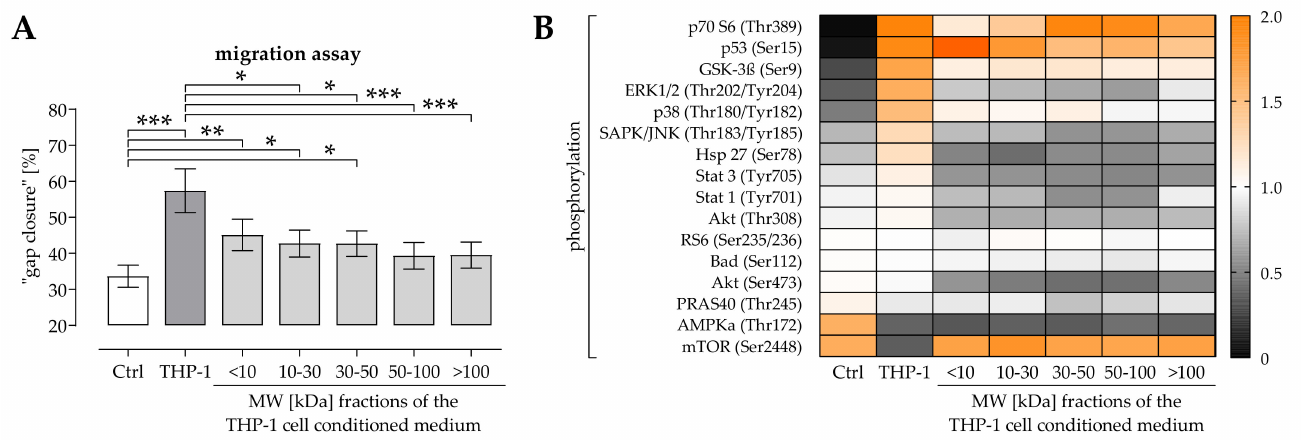
Figure 1. THP-1 cell conditioned medium induces MAPKinase signaling in and cell migration of osteoprogenitor cells. THP-1 cells were cultured for 45 h to obtain THP-1 cell conditioned medium. THP-1 cell conditioned medium was fractioned by molecular weight (MW) with spin columns (Sartorius, Göttingen, GER). ( A ) Migration of osteoprogenitor cells was determined with a scratch assay. Data are presented as bar chart (mean ± 95% C.I.). N = 5 and n = 6. Data were compared by non-parametric Kruskal-Wallis test, followed by Dunn’s multiple comparison test. * p < 0.05, ** p < 0.01 and *** p < 0.0001 as indicated. ( B ) Pools of the corresponding osteoprogenitor cell lysates (30 min stimulation with THP-1 cell conditioned medium) were examined with a PathScan ® Intracellular Signaling Array test to determine activation of intracellular signaling pathways. Mean data are presented as heat map. Ctrl =